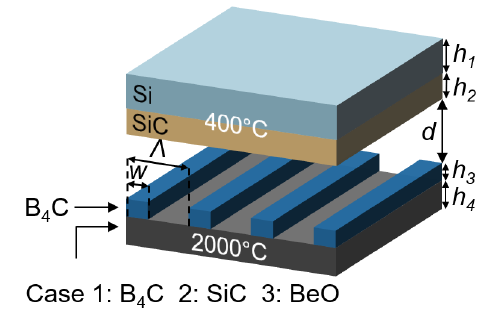
Figure 1. Schematic of the near-field TPV system, consisting of a refractory selective thermal emitter and a SiC/Si tandem cell. The thermal emitter consists of B 4 C gratings with three different substrates: B 4 C (Case 1), SiC (Case 2) and BeO (Case 3). The grating period Λ and the width w are 50 nm and 10 nm, respectively. The temperature of the thermal emitter is maintained at 2000 ◦ C, while the PV cell works at 400 ◦ C. The separation gap d is kept as 100 nm, and the thicknesses of each layer are as follows: h 1 = 200 µ m, h 2 = 2 µ m, h 3 = 50 nm and h 4 = 50